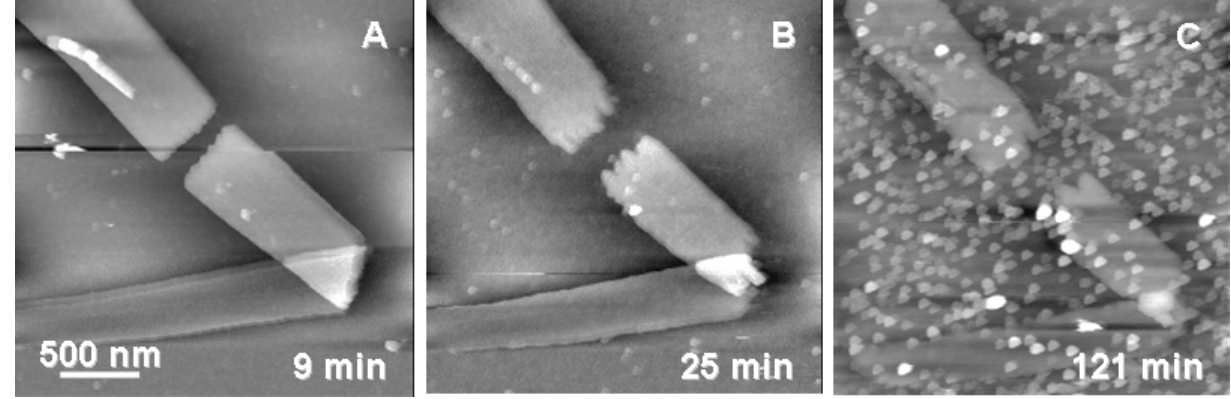
Figure 2. Adsorption and initial degradation of P(3HB) single crystals by PHA depolymerase from R . pickettii T1 [51]. Reproduced with permission from Numata et al ., Biomacromolecules ; published by ACS,